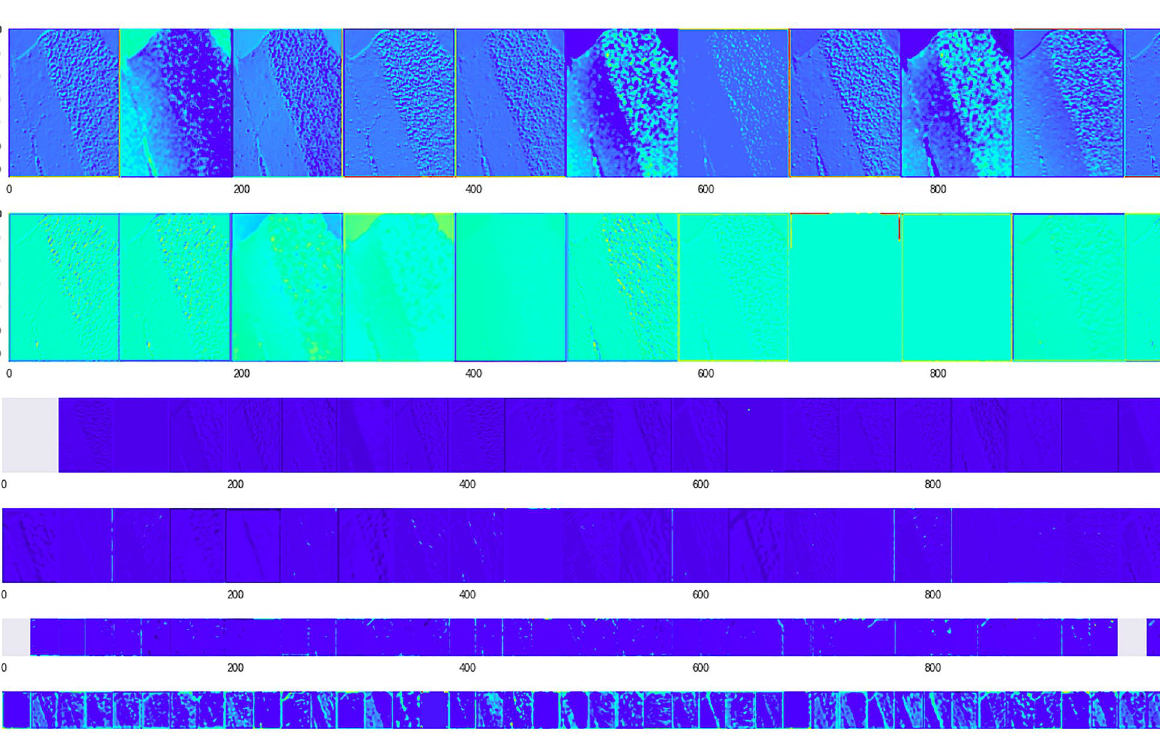
Figure 19. Image of ’cerebellum’ class correctly classified by the VML; there is similarity of the initial first 10 slices of the first convolution layer, with the previous figure (Fig. 18). The granular layer has persisted till the last convolution layers. (Figure generated by Matplotlib python library, version 3.3.4, https:// matpl otlib.